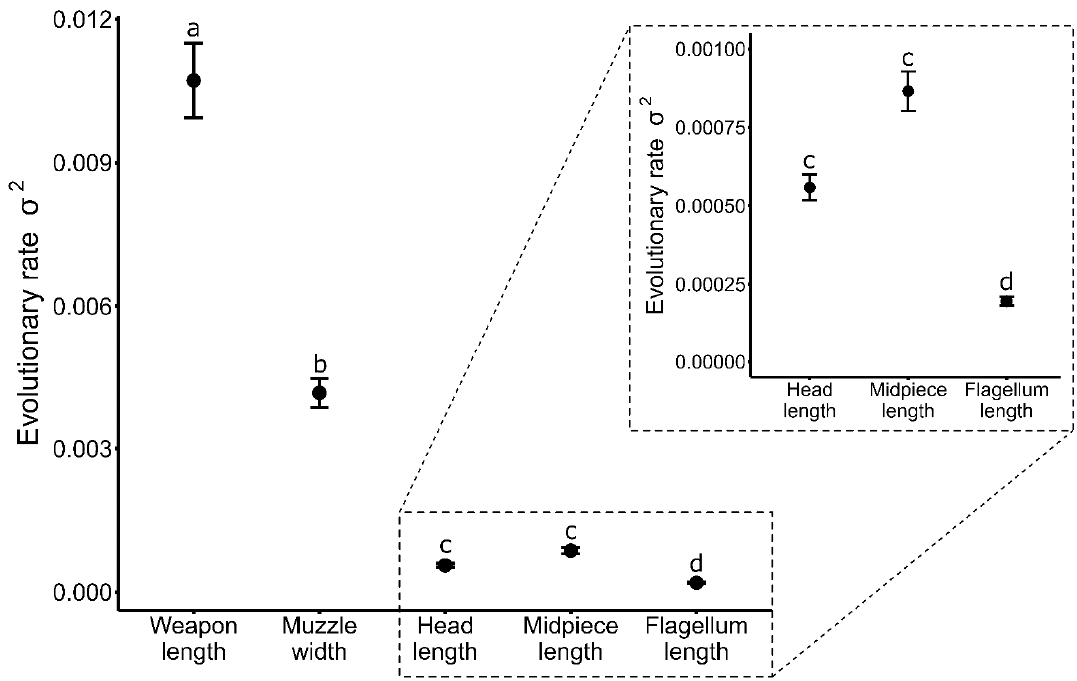
Figure 1. Observed evolutionary rates ( σ 2 ) of phenotypic divergence and 95% confidence intervals of linear traits (weapon length, muzzle width, sperm head, midpiece and flagellum length) in ungulates. Evolutionary rate estimates for sperm dimensions are magnified in the inset plot. Significant differences between traits are denoted by different letters above each point.